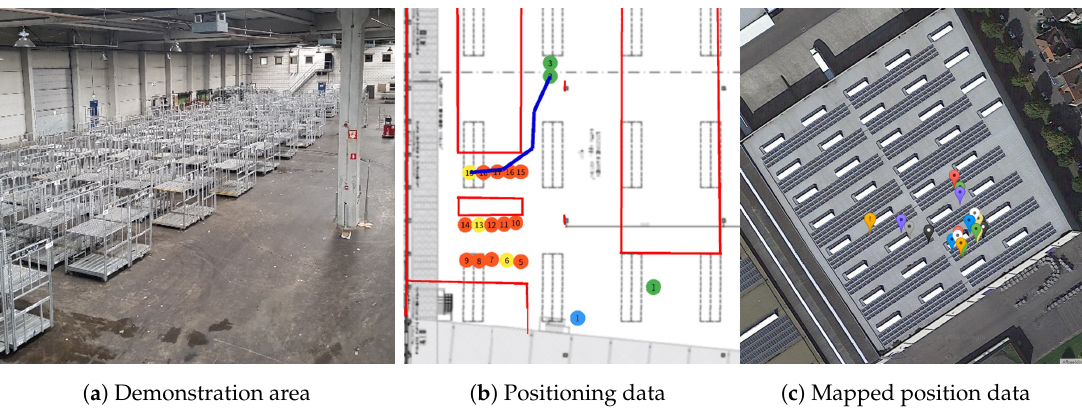
Figure 10. The demonstration of light-weight integration of localization systems targeting the hybrid connected